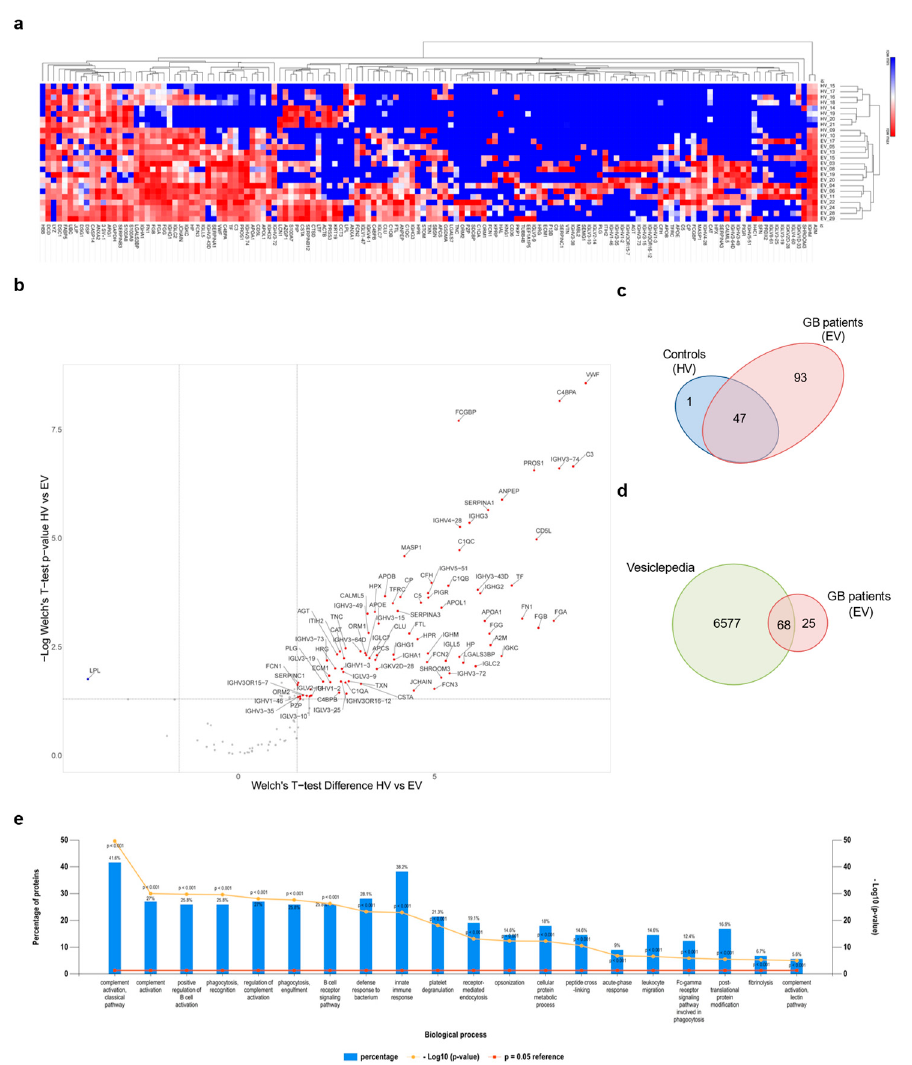
Figure 3. Proteomic analysis of sEV cargo. ( a ) Hierarchical clustering of protein expression in all experimental samples (i.e., healthy volunteers (HVs) and GB patients (EVs)) using Euclidian distance and average linkage, showing a heat map of protein expression for the respective samples (no protein expression in blue to high protein expression in red) and dendrograms for the hierarchical clustering of samples (horizontal dendrogram) and for proteins (vertical dendrogram), respectively. Cluster analysis was performed with the Morpheus online tool. (https://software.broadinstitute.org/morpheus, last accessed 22 November 2021) [42]. ( b ) Volcano plot showing the differentially expressed proteins between HVs and EVs with Welch’s t -test p -values < 0.05 and a log 2 Welch’s t -test difference of at least 1.5 for upregulated proteins (red dots) and − 1.5 for downregulated proteins (blue dots). A volcano plot was created with VolcaNoseR [43]. ( c ) Venn diagram showing the repartition of the identified MS hits between HVs and EVs. ( d ) Venn diagram of proteins enriched in GB-derived sEVs compared with proteins annotated in the Vesiclepedia database. ( e ) Gene enrichment analysis for “biological process” was performed based on MS hits using the FunRich platform. The 20 most significant processes identified are reported.